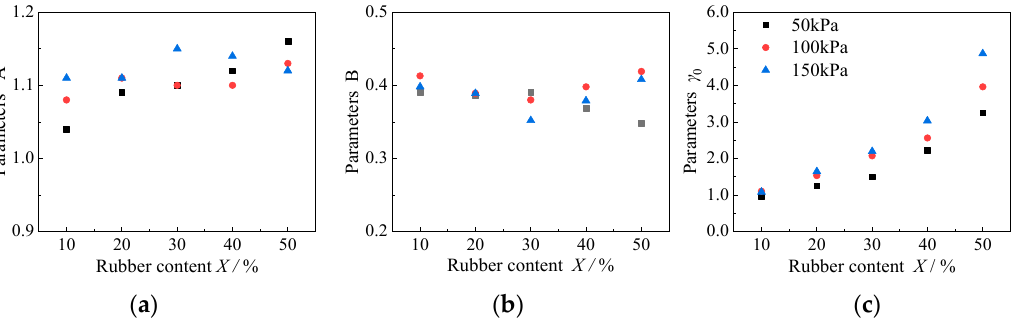
Figure 27. Variation of the model parameters, with the rubber content of the Martin–Davidenkov Model. ( a ) Parameters A, ( b ) Parameters B, ( c ) Parameters γ 0 .